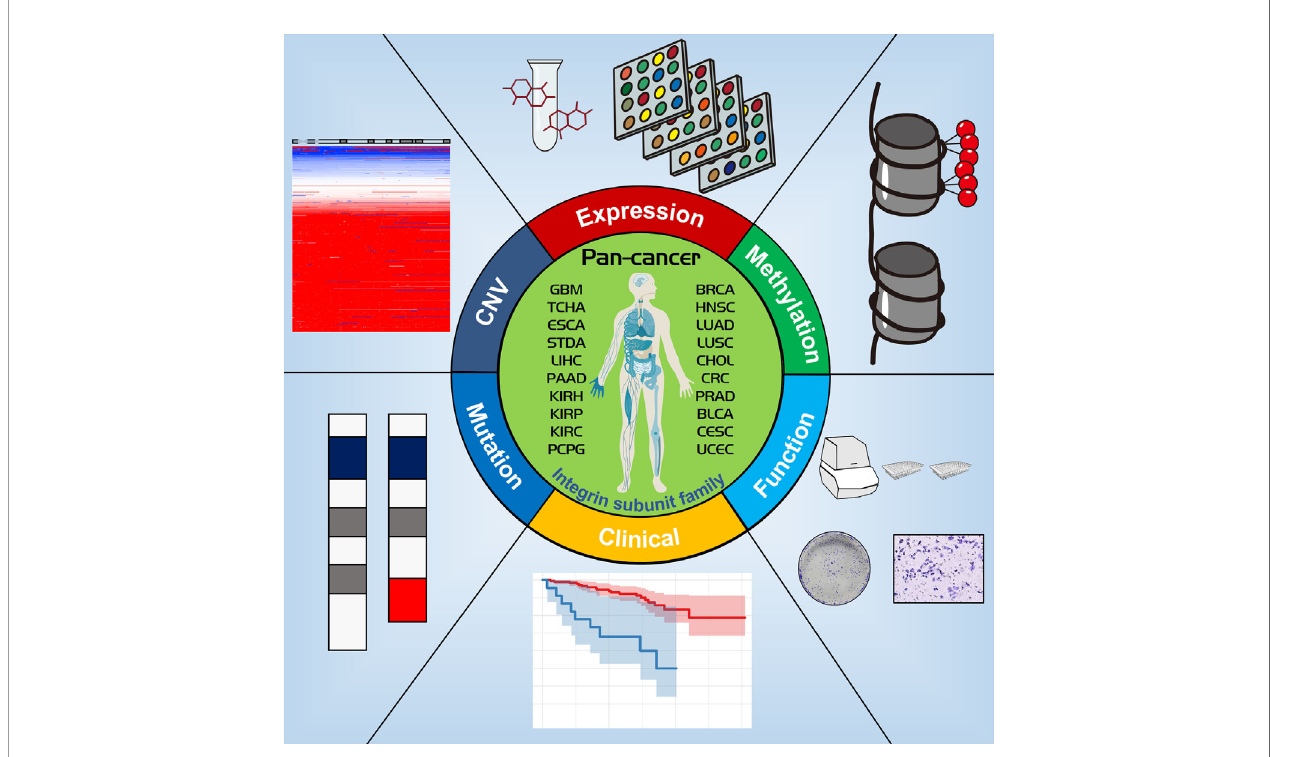
FIGURE 6 | Schema demonstrates Pan-cancer analyses of ITGs in human